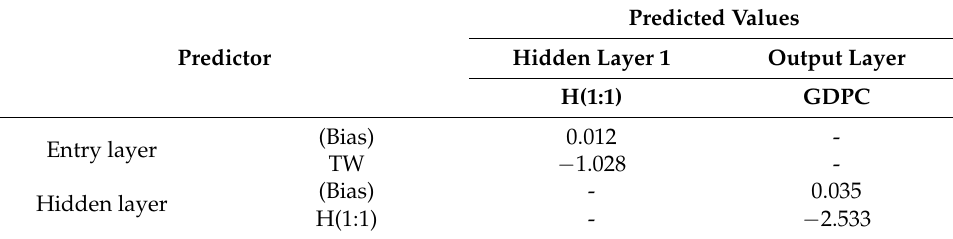
Table 3. The values of the multilayer perceptron model concerning telework (T.W.) and economic performance (GDPC).